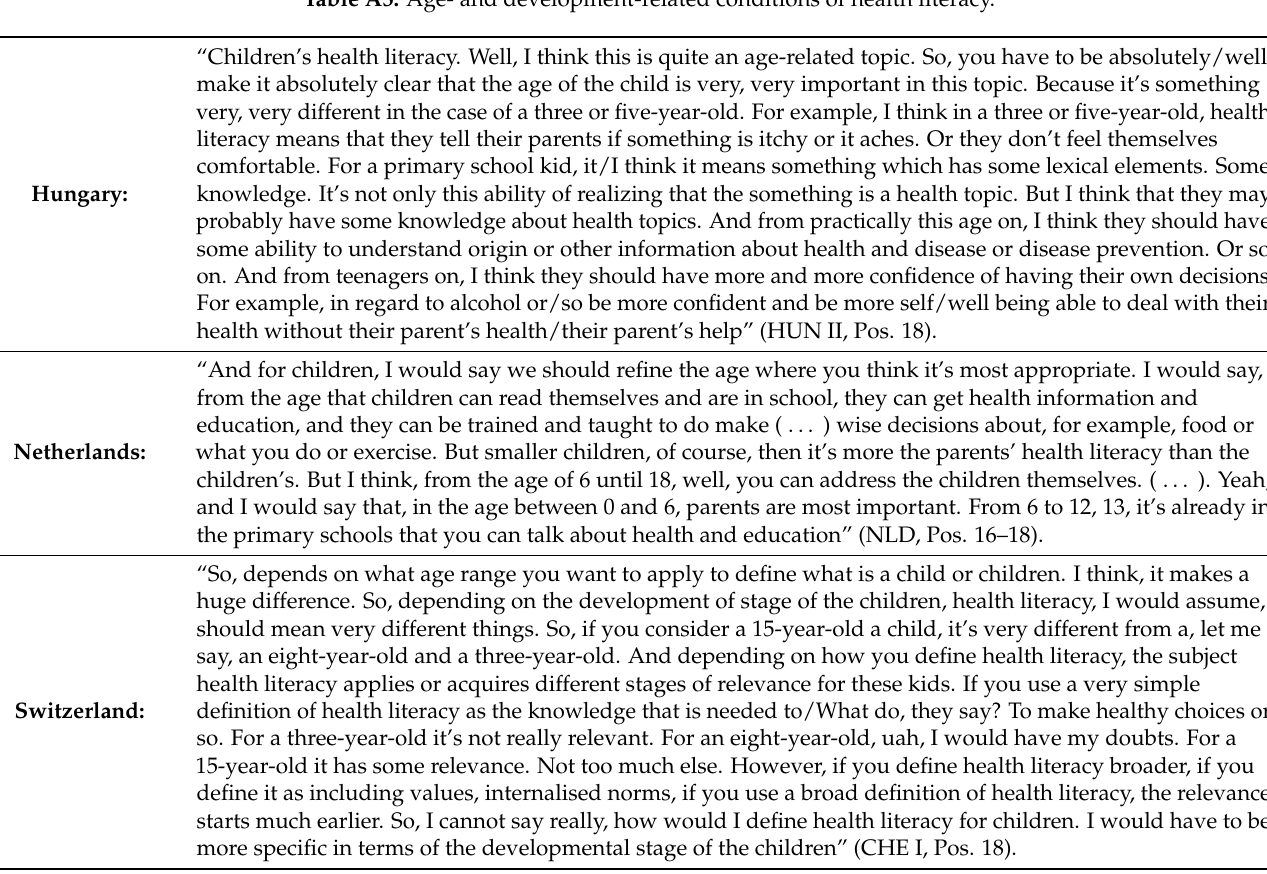
Table A5. Age- and development-related conditions of health